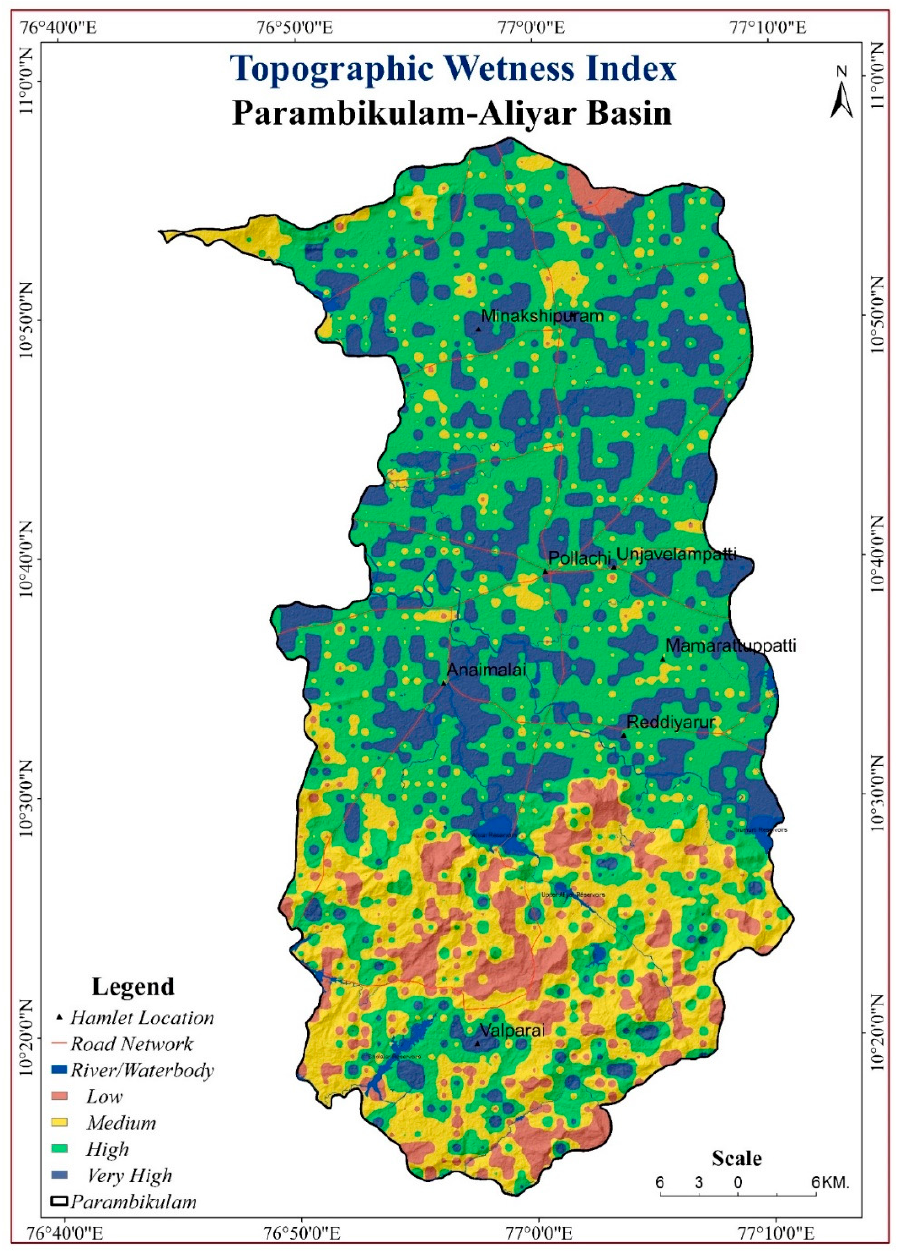
Figure 11. Topographical wetness index for PAP, 2021. Table 2. The mean TWI category in the basin.